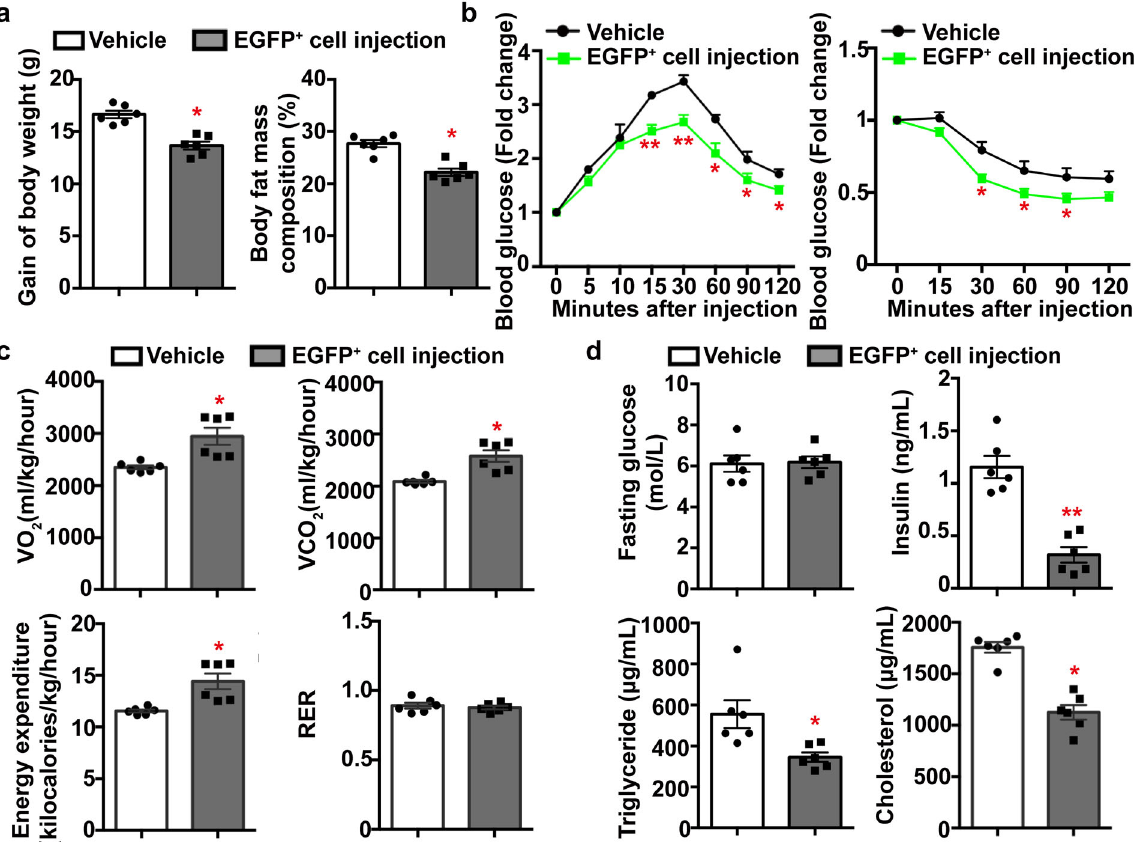
Fig. 5 Treatment with adiponectin-expressing tTreg precursors alleviates HFD-induced metabolic abnormalities. Vehicle or adiponectin-expressing EGFP + cells [30000 cells/ mouse ] isolated from Adn-Cre/ROSA mT/mG mice were injected via tail vein into 4-week-old WT mice, which were then subjected to HFD feeding for another 12 weeks. a At the end of treatment, the gain of body weight and the percentage body fat mass composition were calculated for comparison. b After 10- and 12 weeks of HFD, intraperitoneal glucose ( left ) and insulin ( right ) tolerance tests were performed as described in the Methods. Results are presented as fold changes against the glucose levels at time zero for comparison. c Indirect calorimetry was used to examine the VO 2 , VCO 2 , energy expenditure, and RER as described in the Methods. The 24-h average values were calculated for comparison. d The fasting blood glucose and serum insulin, triglyceride or cholesterol levels were measured after 12 weeks of HFD feeding for comparison. Data are presented as mean ± SEM. *, P < 0.05 and **, P < 0.01 vs corresponding vehicle control groups ( n = 6 biologically independent samples from different animals of independent